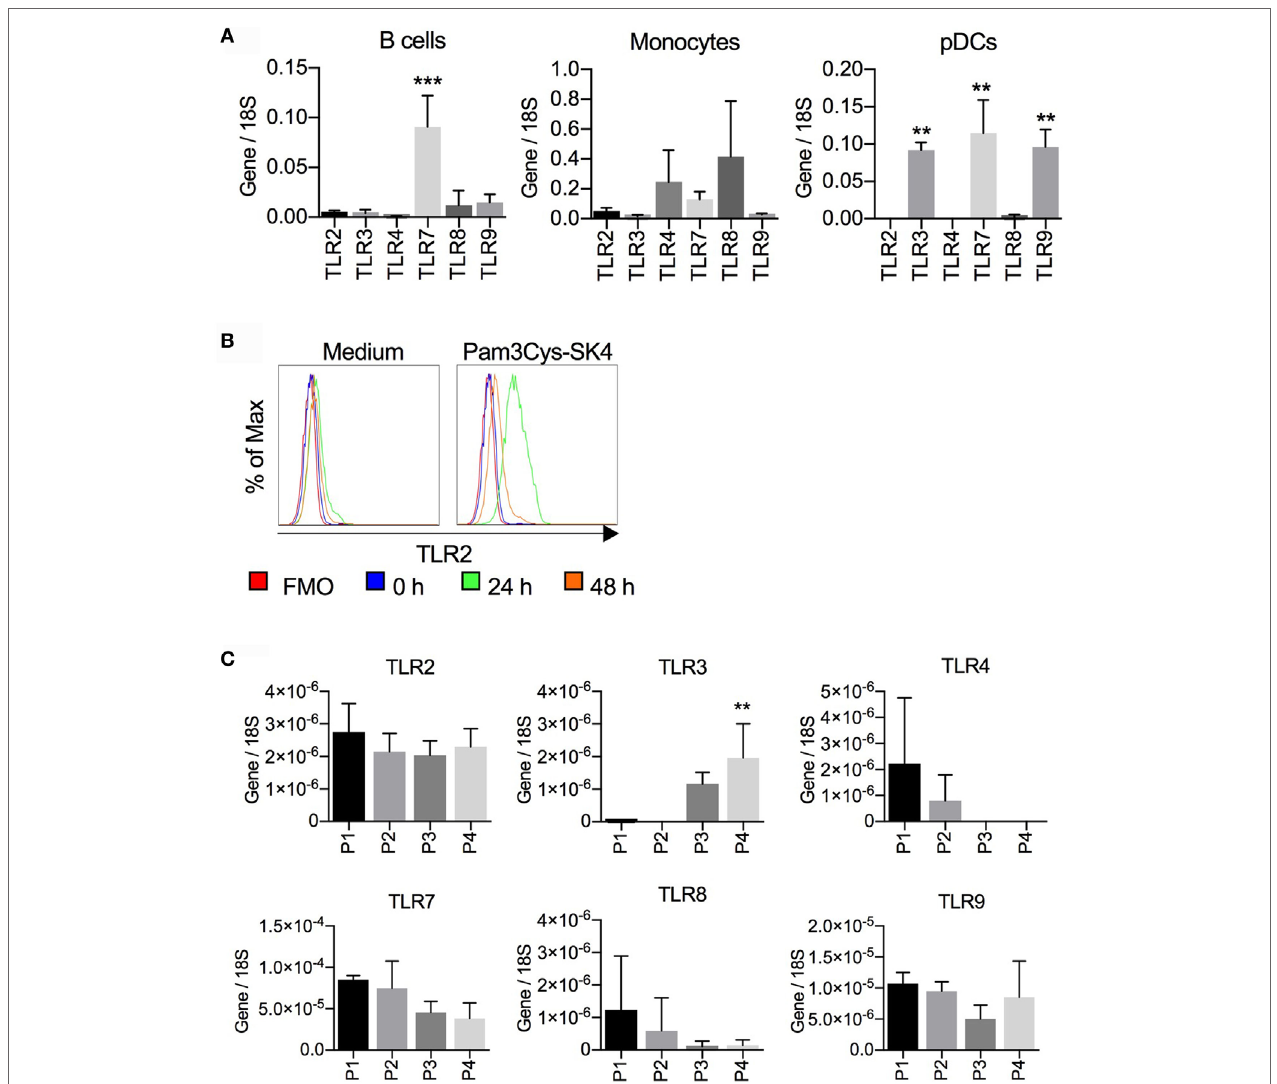
FigUre 6 | Toll-like receptor (TLR) mRNA expression in B cells, monocytes, and plasmacytoid dendritic cells (pDCs). (a) CD21 + B cells and CD14 + monocytes were sorted by magnetic cells sorting (purity > 98%); CD172a + CD4 high pDCs were purified by fluorescence activated cell sorting (FACS) (purity > 99%). RNA was isolated for RTqPCR analysis of TLR expression. Data are from three biological replicates generated using cells from three different pigs. In B cells, TLR7 expression was significantly higher than all other TLR (*** P < 0.0001). In pDC, TLR3, TLR7, and TLR9 were found to be significantly higher when compared to the other TLRs (** P < 0.001). (B) Expression of TLR2 on CD21 + cells after stimulation of peripheral blood mononuclear cells with Pam3Cys-SK4 for 24 h. A representative experiment from three independent experiments is shown. (c) TLR mRNA expression of B cell subsets P1–P4 sorted by FACS according to the gates defined in Figure 2 . Mean values calculated from three different animals with standard deviations are shown. P4 was statistically significant from P1 and P2 for TLR3 expression (* P <